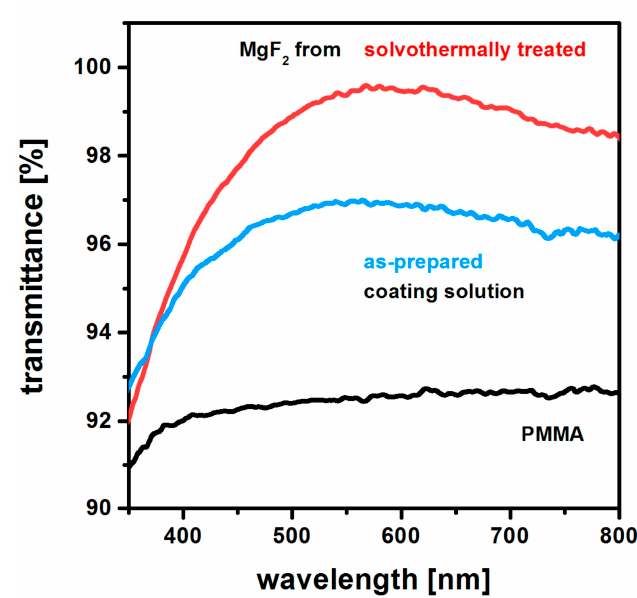
Figure 19. Transmittance of MgF 2 films from solvothermally treated and as-prepared coating solutions. For comparison data from an uncoated, PMMA substrate is given. Based on [53].